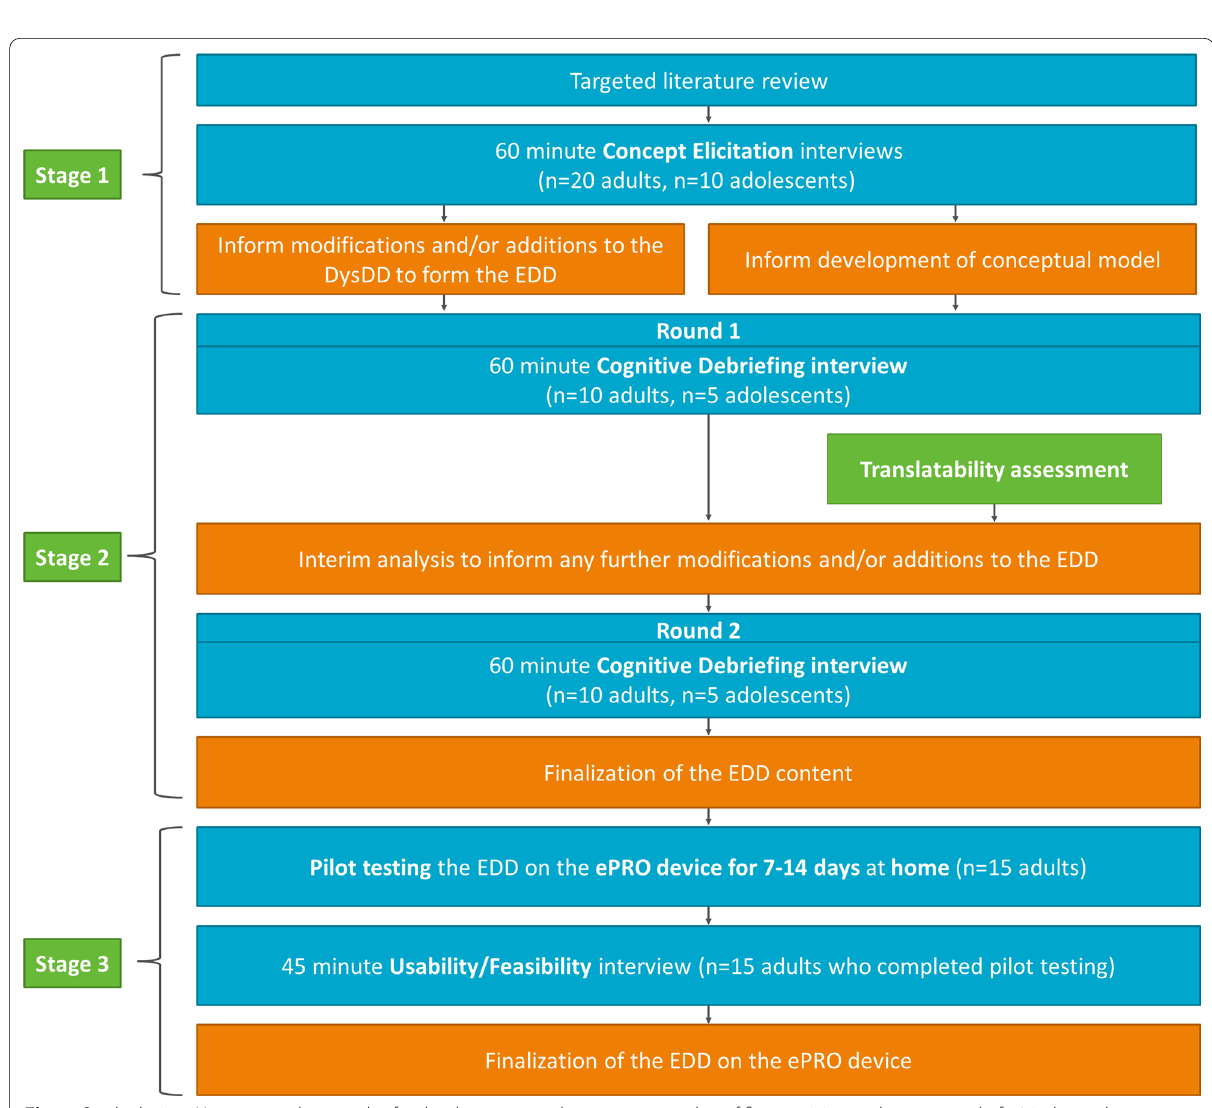
Fig. 1 Study design. Note : across the samples for the three stages, there was an overlap of five participants, hence a total of 70 independent participants were involved in the study (n 3 took park in both a CE and a CD interview; n = feasibility